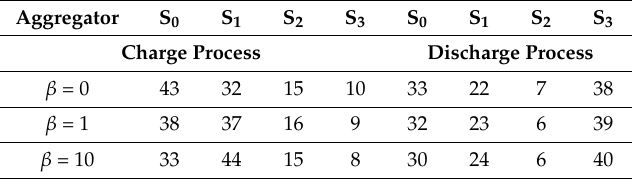
Table 3. Share of all aggregators in different β s in this